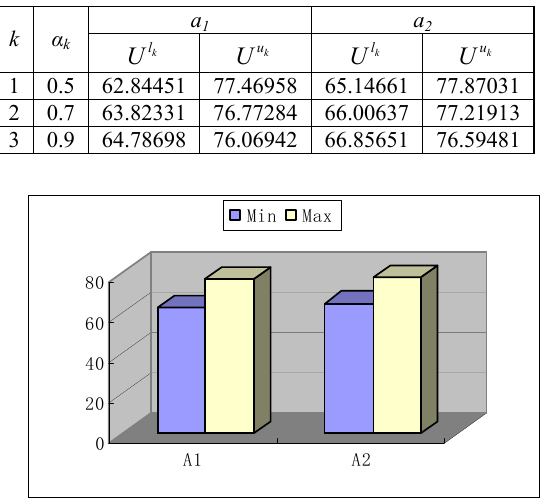
Fig. 13. Global fuzzy belief degrees of a 2 under